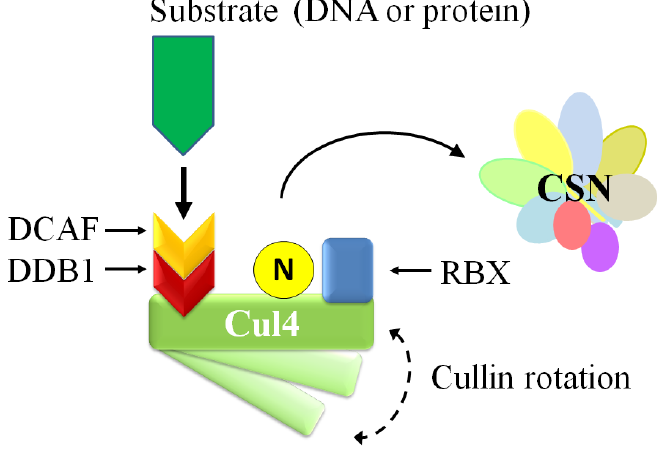
Figure 6. The architecture and activation of CRL4. The CRL4 architecture (adapted